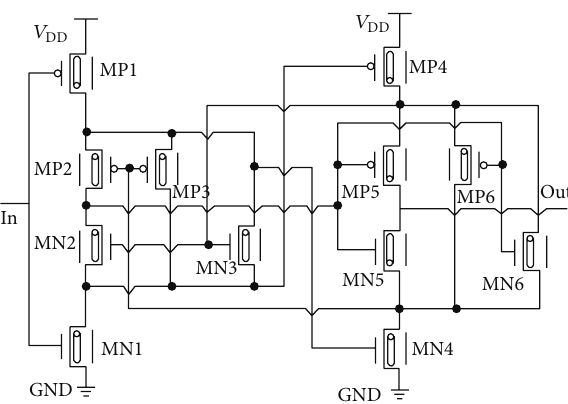
Figure 6: Realization of proposed buffered delay model using